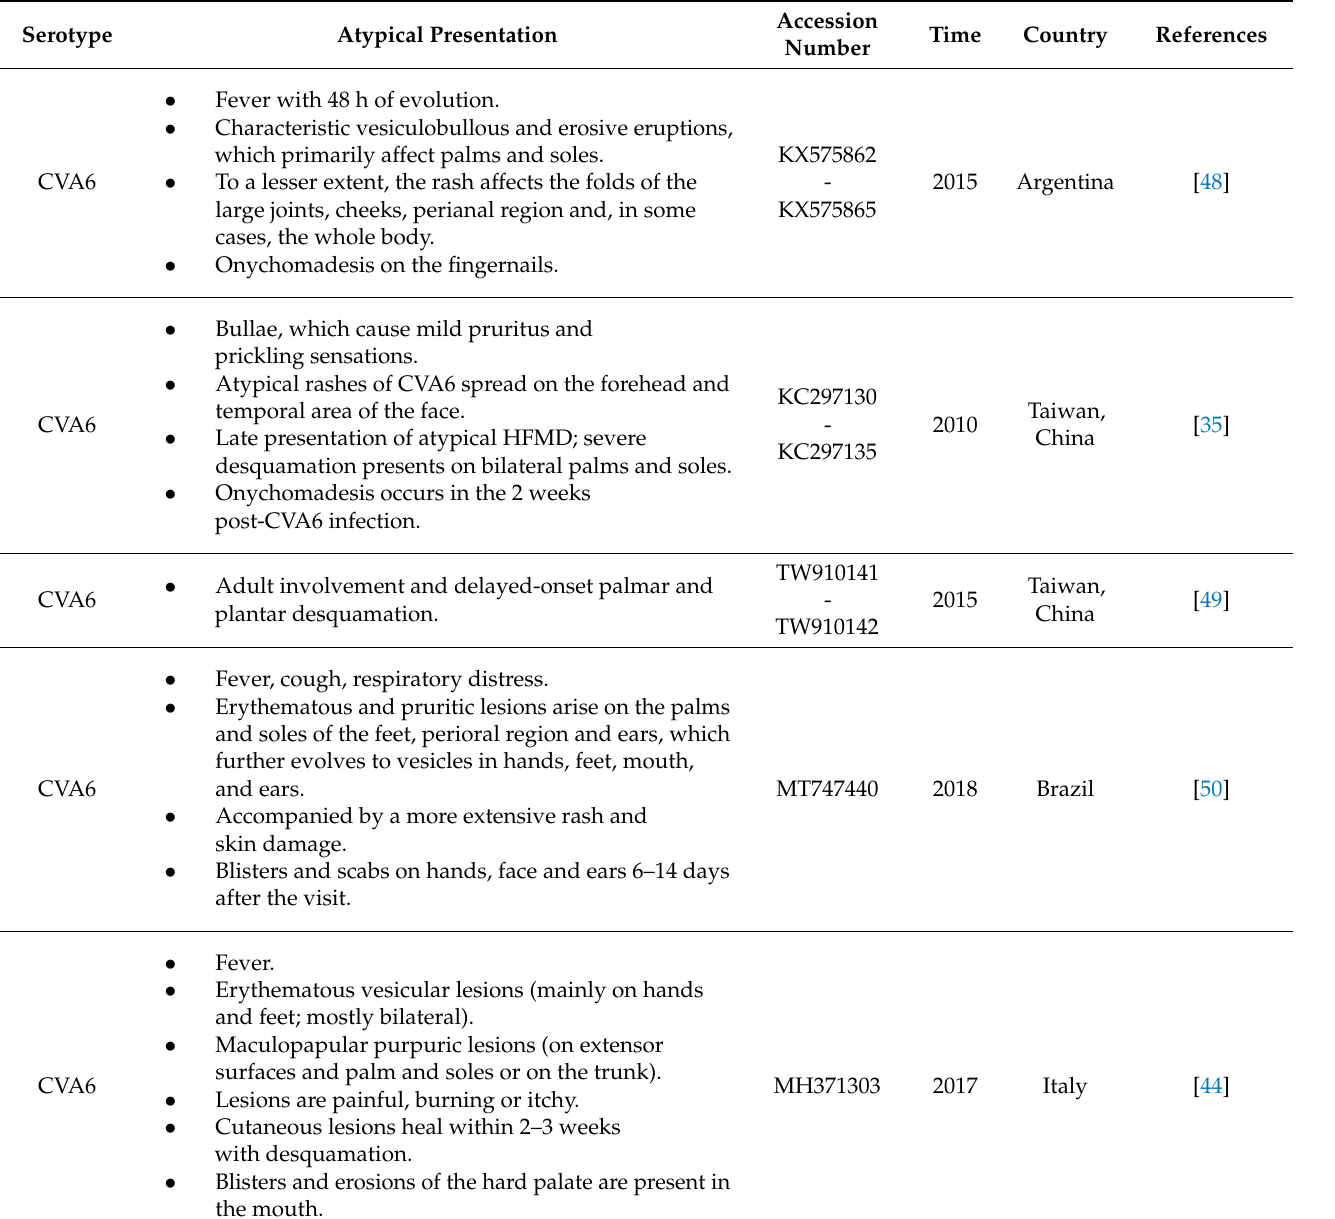
Table 5. Detailed information on virus strains associated with atypical